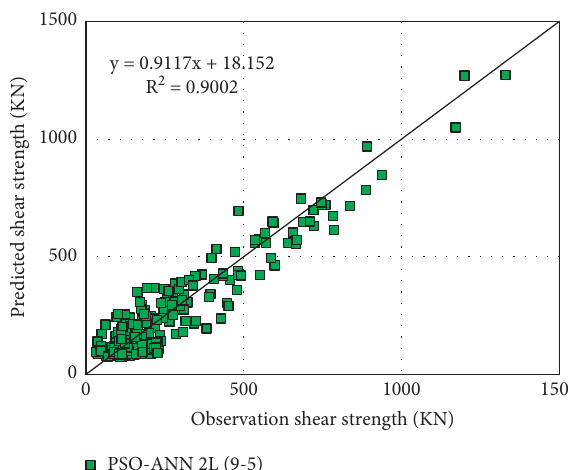
Figure 10: Target (experimental) versus predicted values of shear strength for ANN-PSO 2L (9-5) model using all